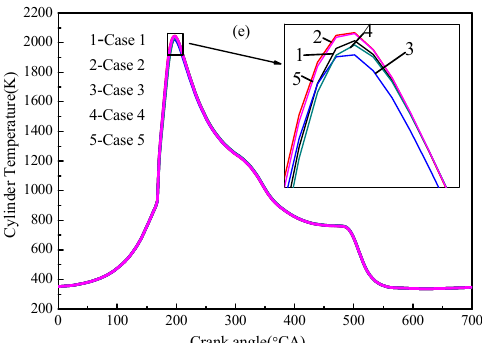
Figure 8. The effects of the injection rate on a diesel engine. ( a ) Pressure; ( b ) Heat release rate; ( c ) Soot generation rate; ( d ) NO x generation rate; ( e ) Cylinder temperature